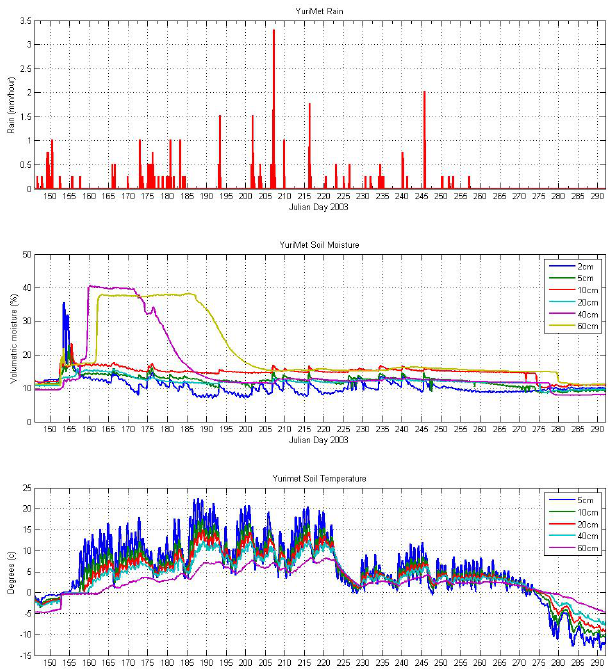
Fig. 2. Rain, soil moisture and soil temperature for 2003. Surface soils thaw between day 150–155 (end of May), with energy from the sun, snowmelt, and rain. Within a week the deeper soils thaw. The surface soils begin drying out quickly once thawed, but a water table persists for several weeks between 20 and 40cm depth, indicating water storage, likely from snowmelt and early rain as the soils at depth were dry at the end of the previous summer. This water drains about the time the outlet river opens up in early July. Variations after this point are caused by rainfall, which do reach the 40cm level quickly, indicating good hydraulic conductivity. Soils then freeze with little trapped moisture between days 273–280 (early